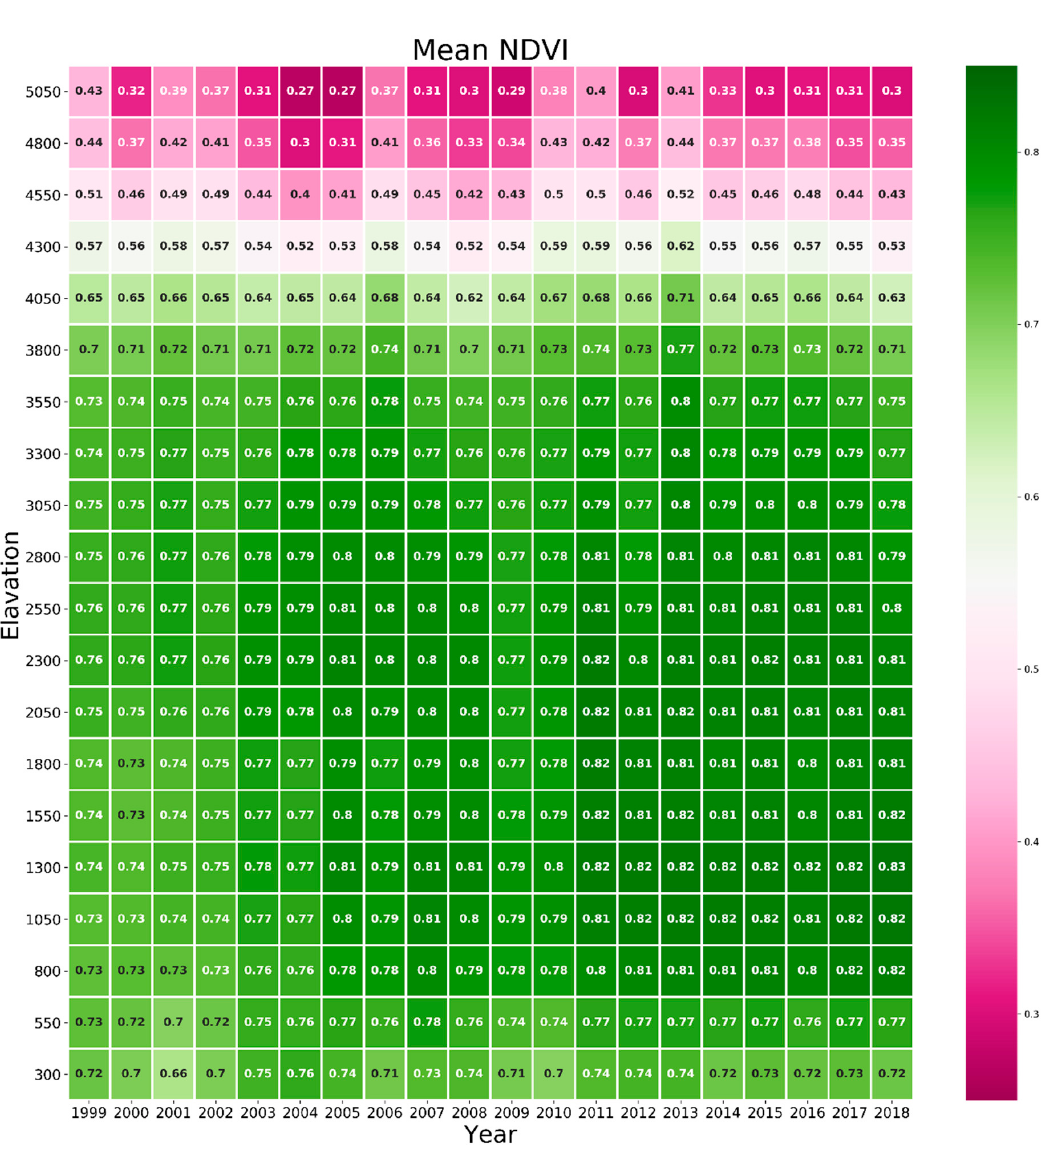
Figure 12. NDVI from 1999 to 2018, at elevations between 250 m and 6000 m.